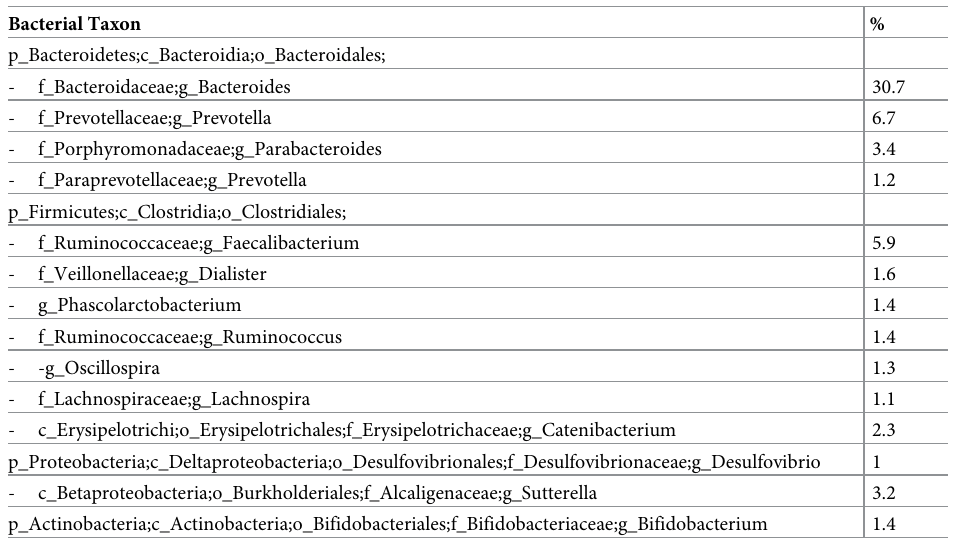
Table 2. Abundance of the most prevalent genera in the entire